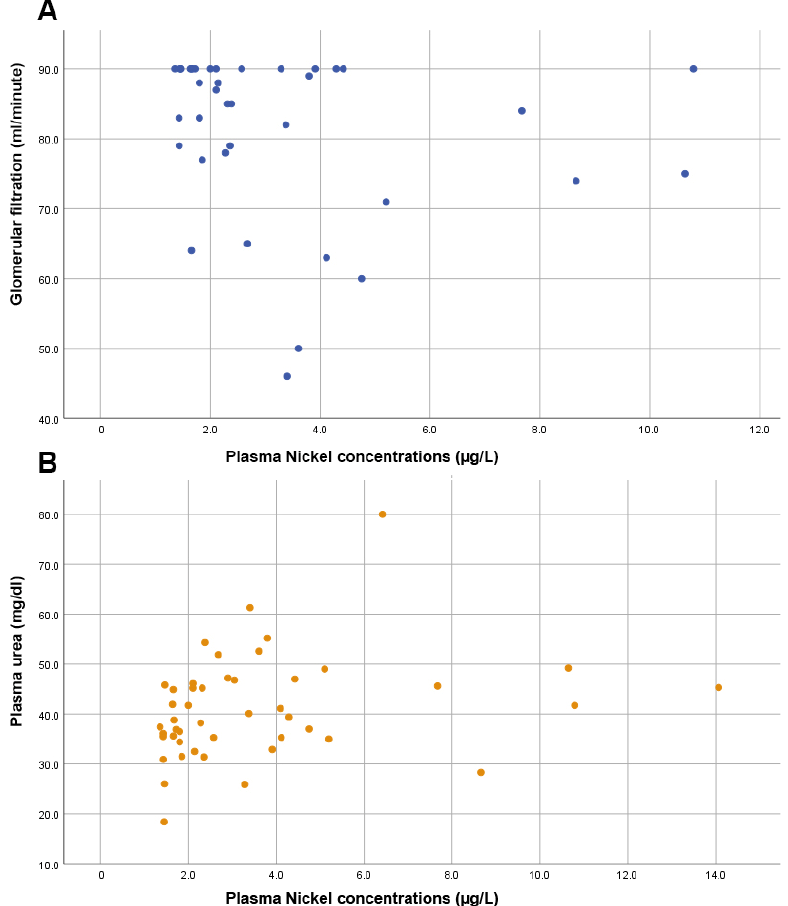
Figure 3. Scatter plots showing ( A ) an inversely proportional correlation between glomerular filtration and nickel levels; ( B ) the direct proportional correlation between plasma urea levels and plasma nickel levels.